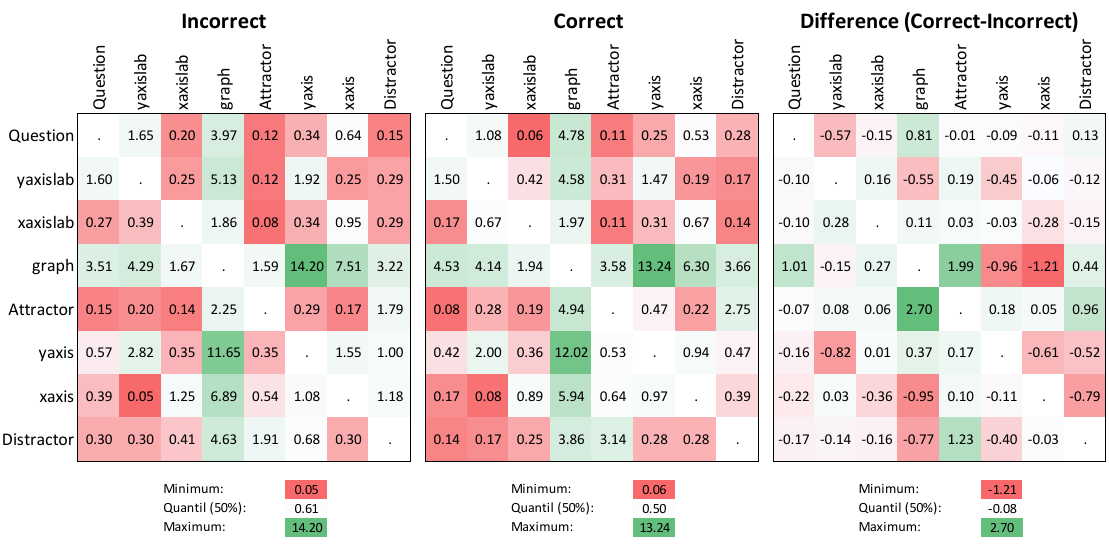
Figure 4. Proportion of the transitions (%) for incorrect (top) and correct solvers (bottom). The color illustrates the difference plot of relative transition frequency differentiated by the 50% quantile (white, incorrect solver: 0.61, correct solver: 0.50) from very rare (intense red) to very frequent (intense green). Table 4. Correlations between the direction of transitions for incorrect and correct solvers. Incorrect Solvers Correct Solvers Correlation R